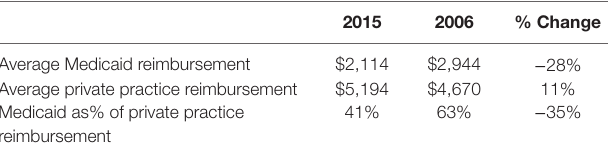
Table 7 | Comparison of adolescent orthodontic treatment reimbursement rates 2006 and 2015.